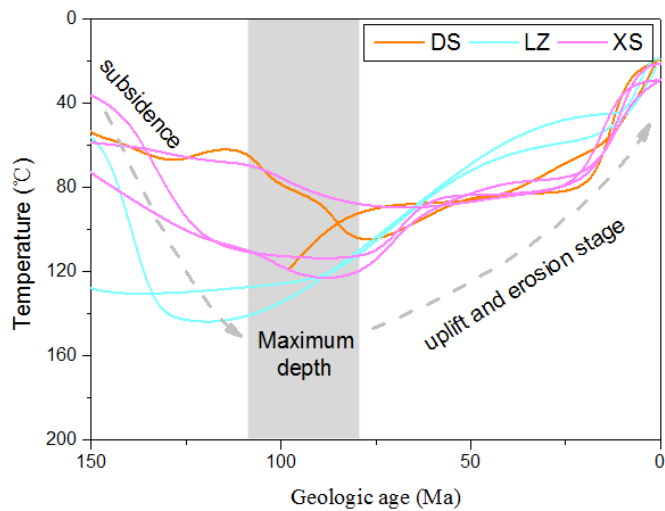
Figure 6. Modeling results of well CN. Burial, thermal and maturity histories of the O 3 w – S 1 l black shales.